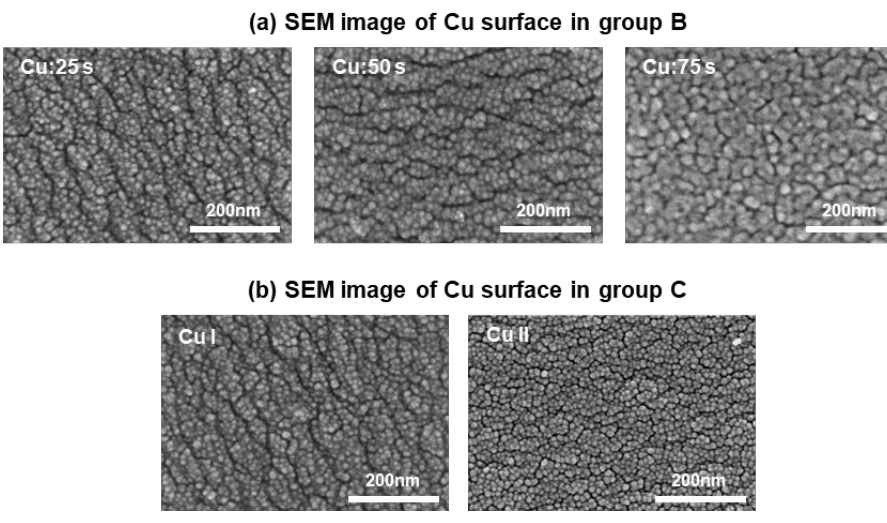
Figure 4. SEM images of the Cu surface for the samples in ( a ) group B and ( b ) group C.